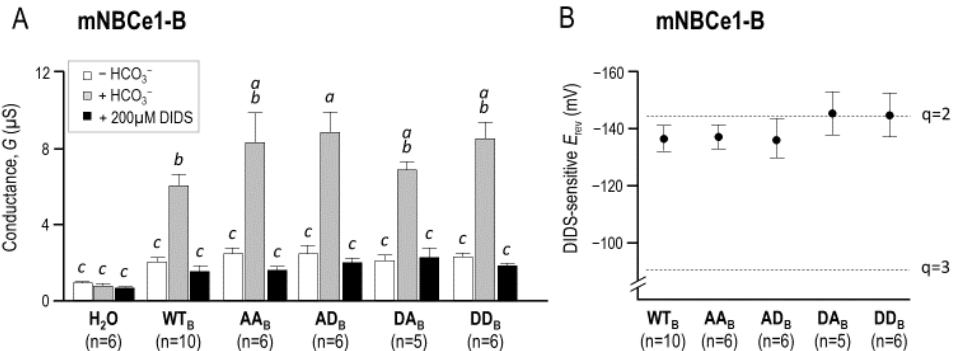
( p < 0.01) when dimers alone were quantified, and an average increase of 29% (n.s.) when monomers alone were quantified.